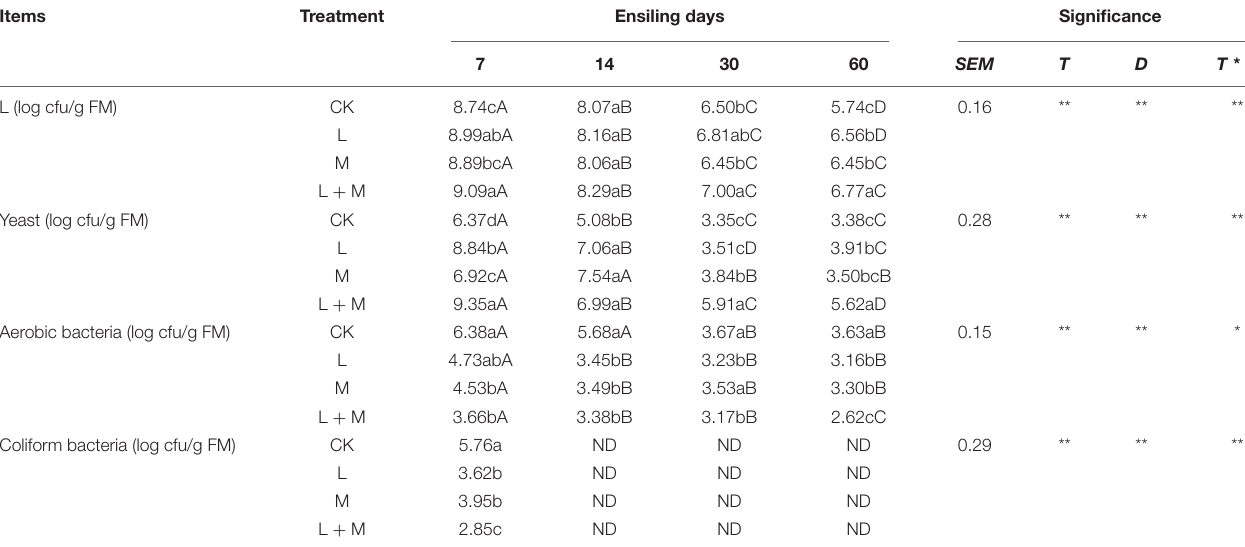
TABLE 4 | Effect of additives and ensiling days on microorganism counts of native grass silages. Items Treatment Ensiling